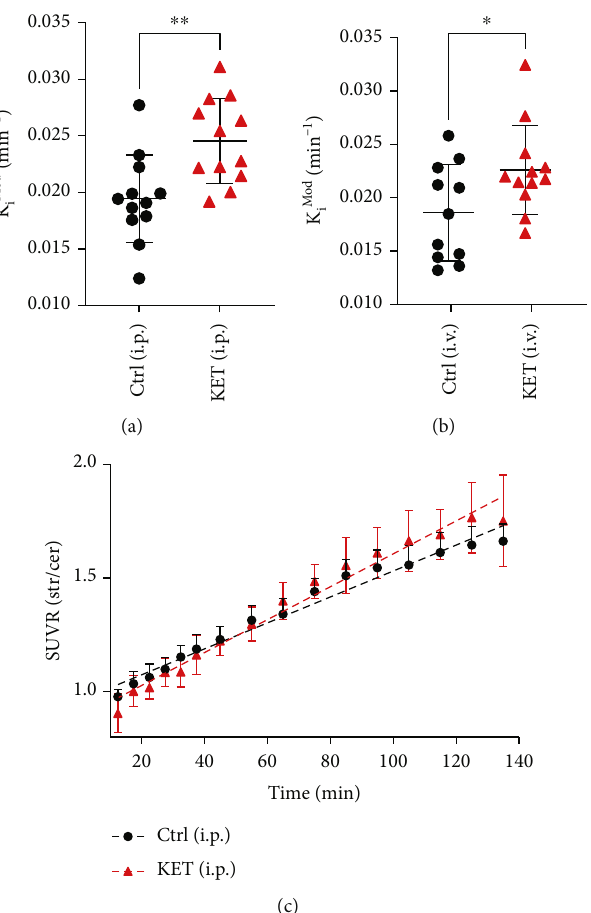
Figure 5: The e ff ect of subchronic ketamine administration on dopamine synthesis capacity measured by two di ff erent routes of [ 18 F]- FDOPA administration. (a, b) K i Mod calculated using (a) 20-140 minutes of the TAC and extended Patlak analysis following i.p. administration or (b) 15-120 minutes of the TAC following i.v. administration of [ 18 F]-FDOPA in naïve (Ctrl) or ketamine-treated (KET) animals. Values are mean ± S : D : ; N = 12 (Ctrl, i.p.; KET, i.p.; KET, i.v.) or N = 11 (Ctrl, i.v.); ∗ p < 0 : 05 , ∗∗ p < 0 : 01 , unpaired